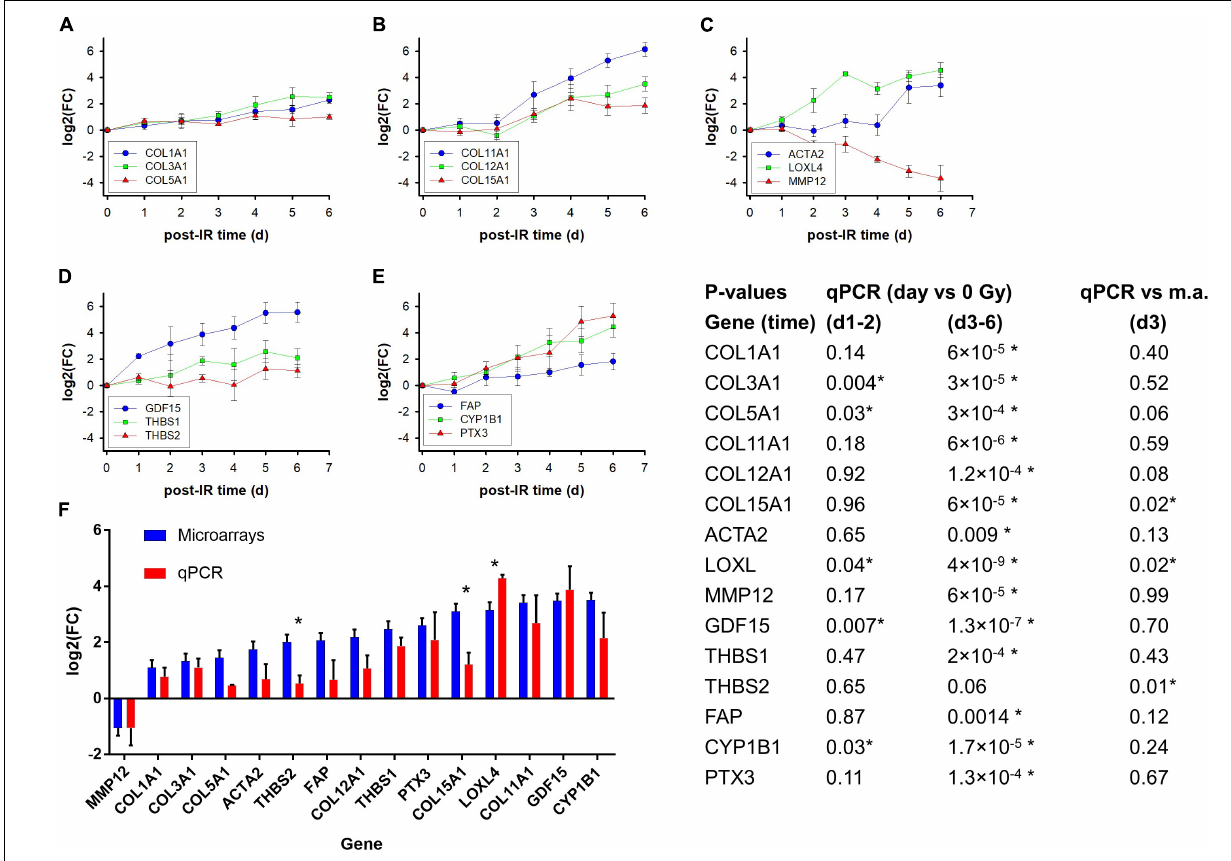
FIGURE 6 | Kinetics of gene expression (fold induction determined with qPCR) of selected genes on day 1–6 after irradiation of GS3, GS4, and GS5 fibroblasts with a single dose of 4 Gy; mean values and standard errors of n = 3 independent experiments are shown (A–E) . Comparison of log2 fold changes [log2(FC)] for microarrays and qPCR on day 3 after a single dose of 4 Gy. The microarray and qPCR assays were performed on RNA from GS3, GS4, and GS5 irradiated in separate, independent experiments; Mean values and standard errors are shown (F) . The table shows P -values for log2(FC) of irradiated samples relative to unirradiated controls at early time points (day 1–2 together) and late time points (d3–d6 together) for the qPCR experiments (heteroscedastic t -test, N = 9 and 15, respectively) and for qPCR versus microarrays (m.a.) from experiments #3–5 for GS3, GS4, and GS5 (unpaired t -tests, N = 6). Asterisks indicates P < 0.05.